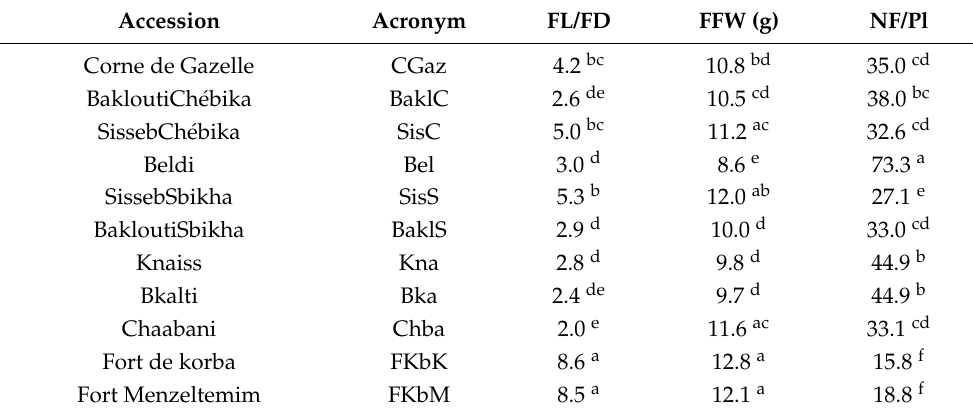
Table 3. Biometric traits of the eleven Tunisian chili pepper accessions under